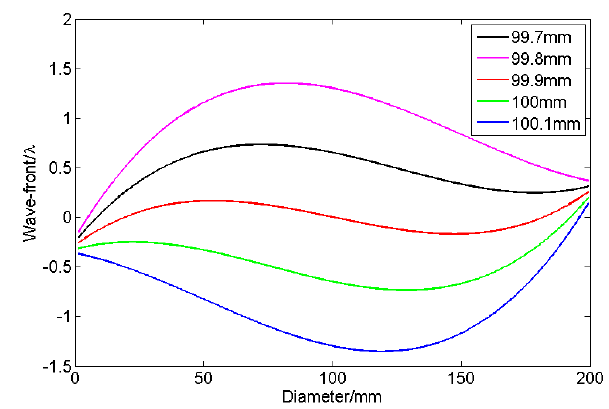
Figure 6. Wavefront fitting results.